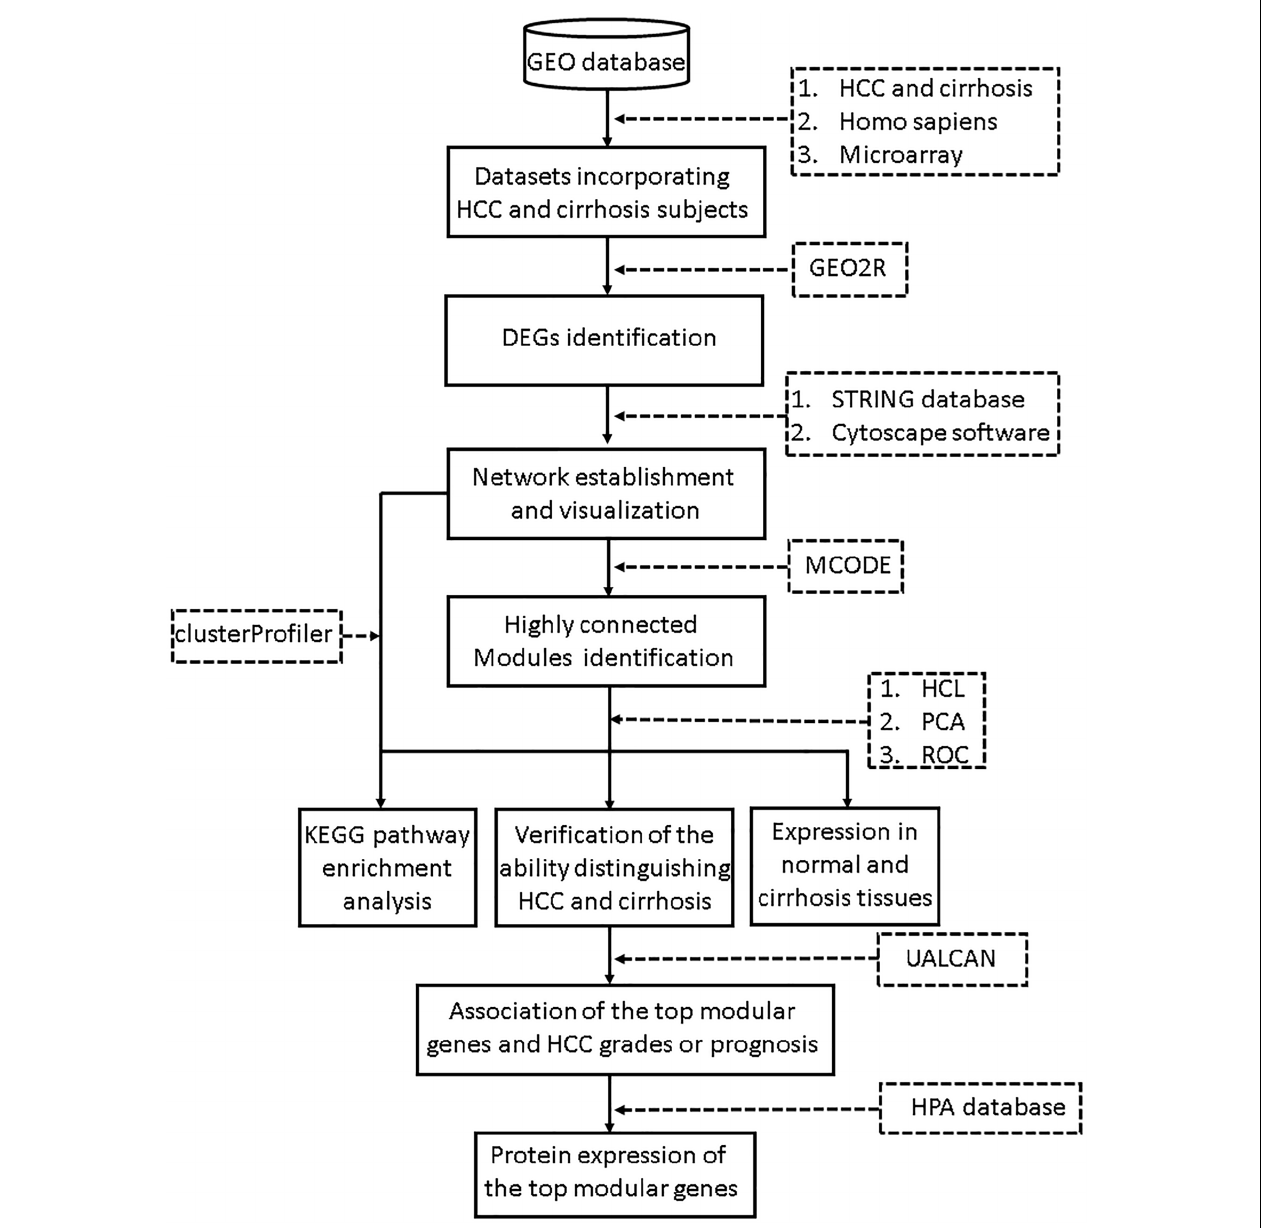
FIGURE 1 | Workflow for bioinformatics analysis. GEO, Gene Expression Omnibus; HCC, hepatocellular carcinoma; STRING, Search Tool for the Retrieval of Interacting Genes; MCODE, Molecular Complex Detection; HCL, hierarchical clustering; PCA, principal component analysis; KEGG, Kyoto Encyclopedia of Genes and Genomes; HPA, Human Protein Atlas. ROC, receiver operating